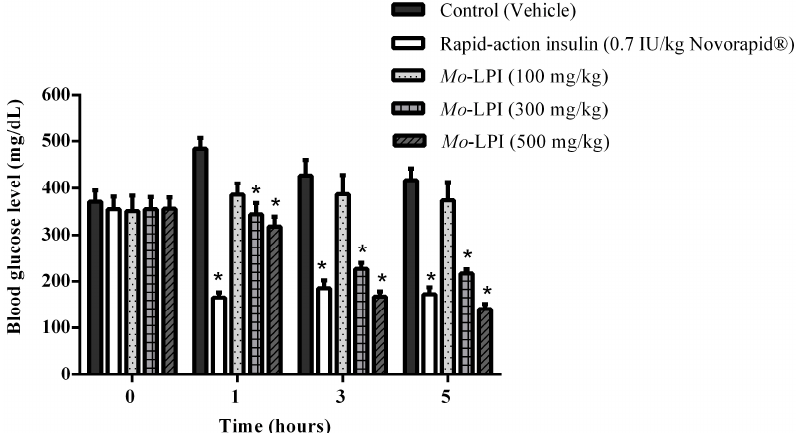
Figure 4. Effect of intraperitoneal administration of Mo -LPI on blood glucose level in alloxan-induced diabetic mice. Values are means ± S.E.M. ( n = 10). Control: vehicle (0.05 M Tris-HCl, pH 7.5, containing 0.15 M NaCl). * Significant ( p < 0.01) difference when compared with the corresponding value of the control at the same time.